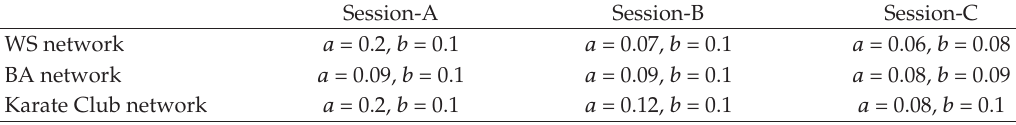
Table 3: Parameters a and b , running on 3 social networks with 3 TianYa